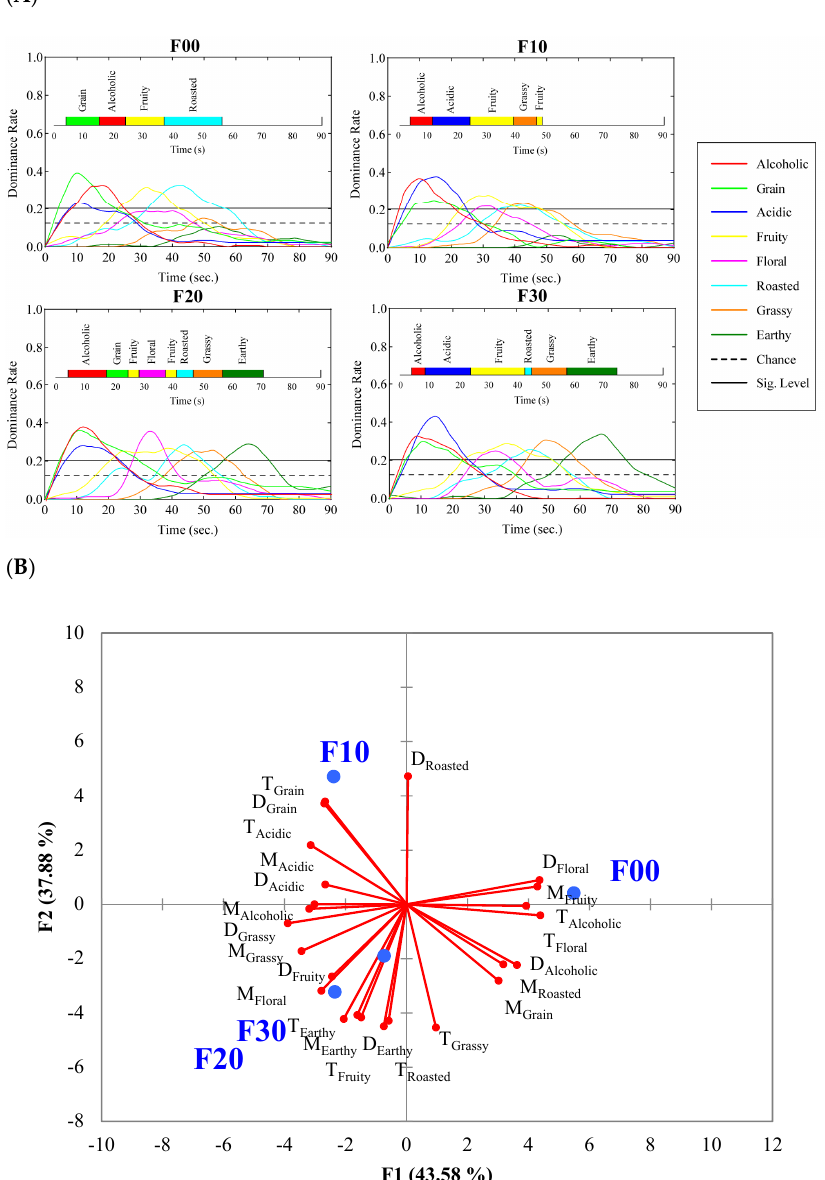
Figure 2. ( A ) TDS curves of four different grades of FJ. Notations: Chance level is defined as the dominance rate that an attribute can be obtained by chance, and its value is equal to the reciprocal of the attribute number. The significance level represents the minimum value the dominance rate should equal to be considered significantly higher than the chance level. It is calculated using the confidence interval of a binomial proportion based on a normal approximation. ( B ) PCA score plot based on the parameters that summarize the TDS curves of four samples. M = maximum dominance rate, T = time of the maximum dominance, D = Time interval when the dominance rate is ≥ 90% of the maximum dominance